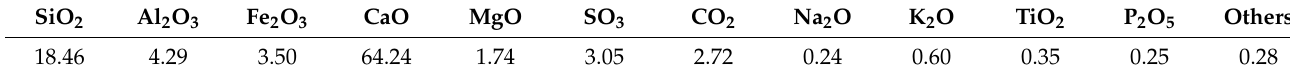
Table 1. Chemical composition of Portland cement (% by mass).